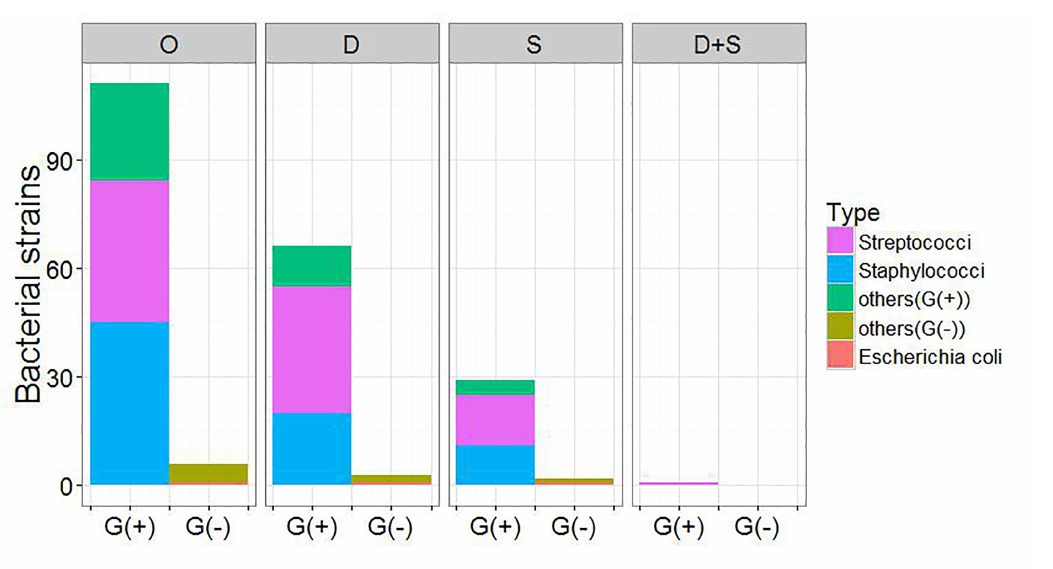
Fig. 2. The number and type of gram-positive bacteria strains (include G (+)) and gram-negative bacteria strains (G (-)) in each